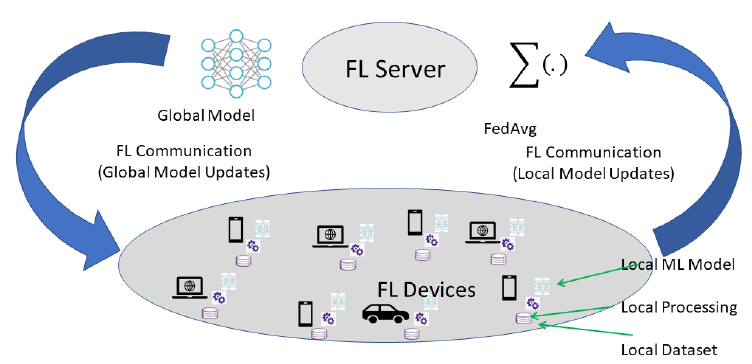
Figure 3. Federated learning framework.